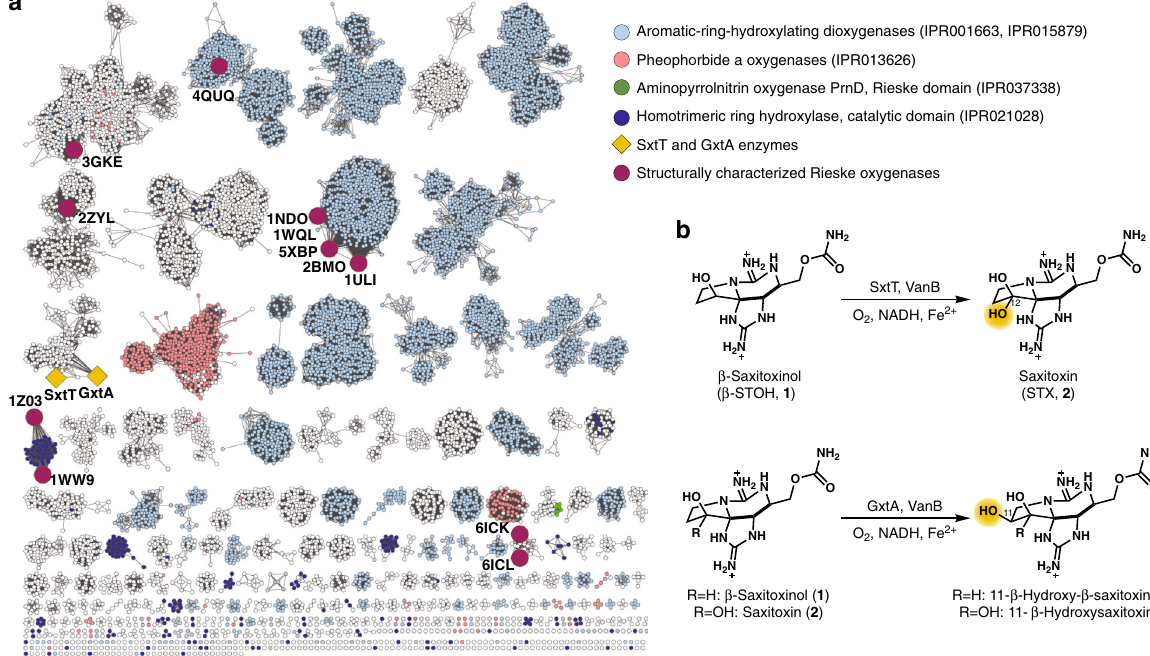
Fig. 1 Extent of characterization of the Rieske oxygenase enzyme superfamily. a Sequence similarity network of Rieske oxygenases (Pfam PF00355) generated by the EFI-EST 59 server at an E-value of 5 and alignment score of 65, visualized in Cytoscape v3.7.1 60 . The network shown was trimmed to include only Rieske proteins that contain the non-heme iron catalytic domain (IPR017941, IPR005805, and IPR domains listed in the fi gure). PDB codes represent the fi rst structure determined for each enzyme. 1ULI, biphenyl dioxygenase; 5XBP, nitroluene dioxygenase; 1NDO, naphthalene dioxygenase; 1WQL, cumene dioxygenase; 2BMO, nitrobenzene dioxygenase; 1WW9, carbazole 1,9 α -dioxygenase; 1Z03, 2-oxoquinoline 8-monooxygenase; 3GKE, dicamba monooxygenase; 4QUQ, stachydrine demethylase; 2ZYL, 3-ketosteroid-9- α -hydroxylase; 6ICK, NdmA; 6ICL, NdmB. b Rieske monohydroxylases SxtT and GxtA catalyze highly selective C – H functionalization reactions in paralytic shell fi sh toxin